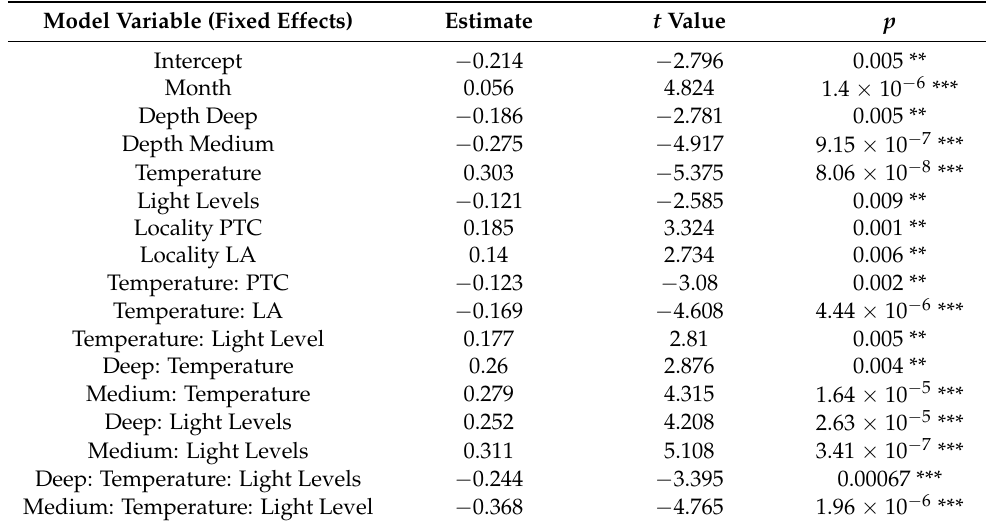
Table 2. Linear Mixed Model (LMM) results fit by maximum likelihood t -tests using Satterthwaite. ** and *** represent level of